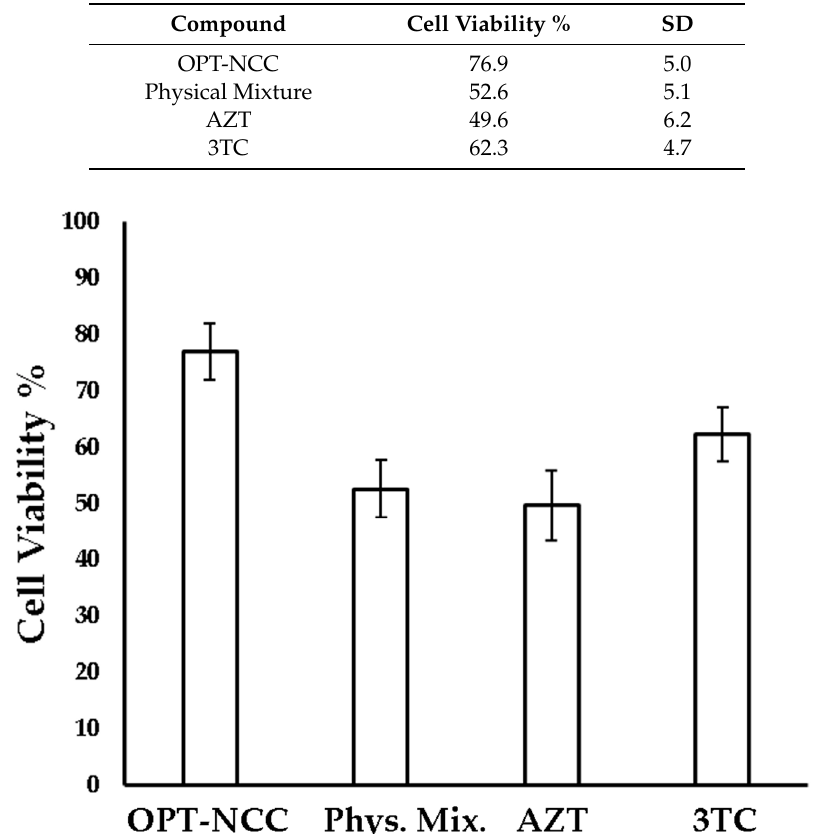
Figure 9. Cytotoxicity of NCC, individual API and physical mixture of active pharmaceutical ingredient